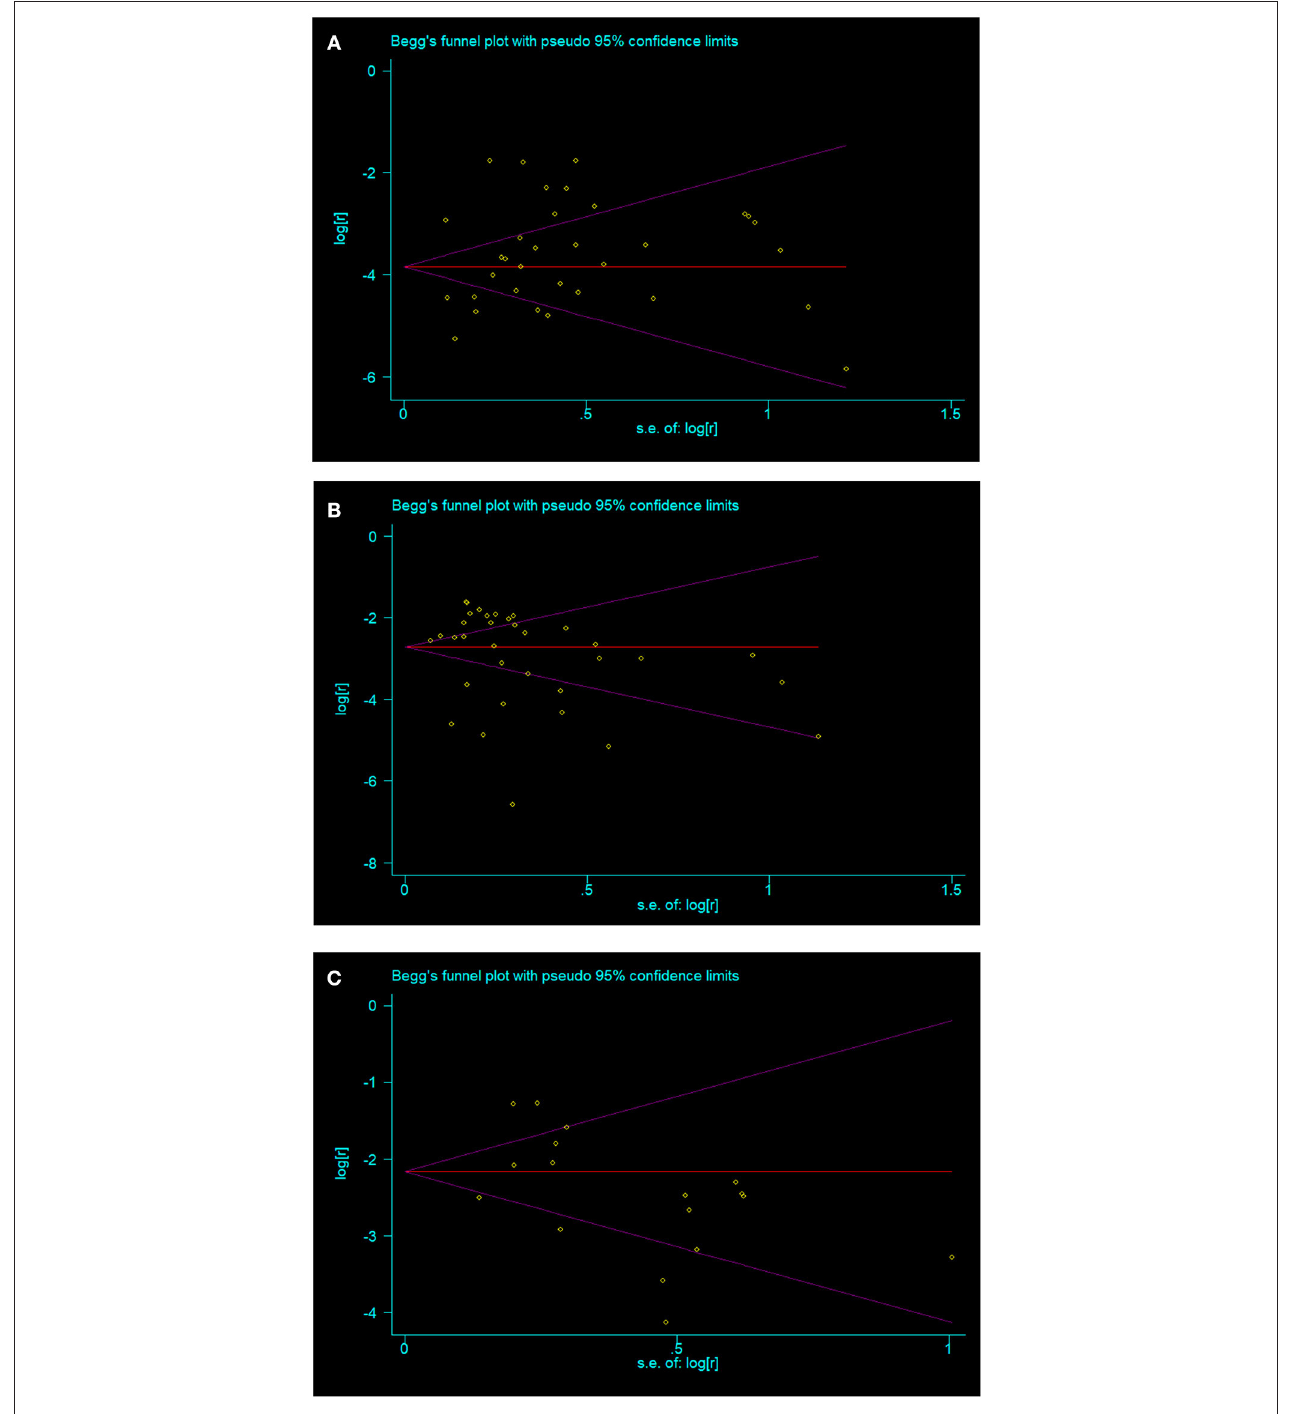
FIGURE 3 | The three thyroid disorders in vitiligo patients with no publication bias (A) overt hyperthyroidism; (B) overt hypothyroidism; (C) subclinical hypothyroidism.